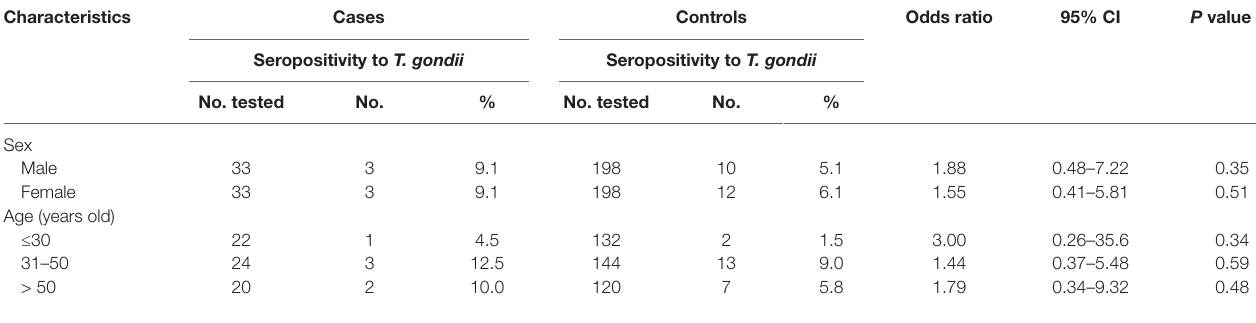
TABle 1 | Stratification by sex and age in cases and controls and seropositivity rates to Toxoplasma gondii .